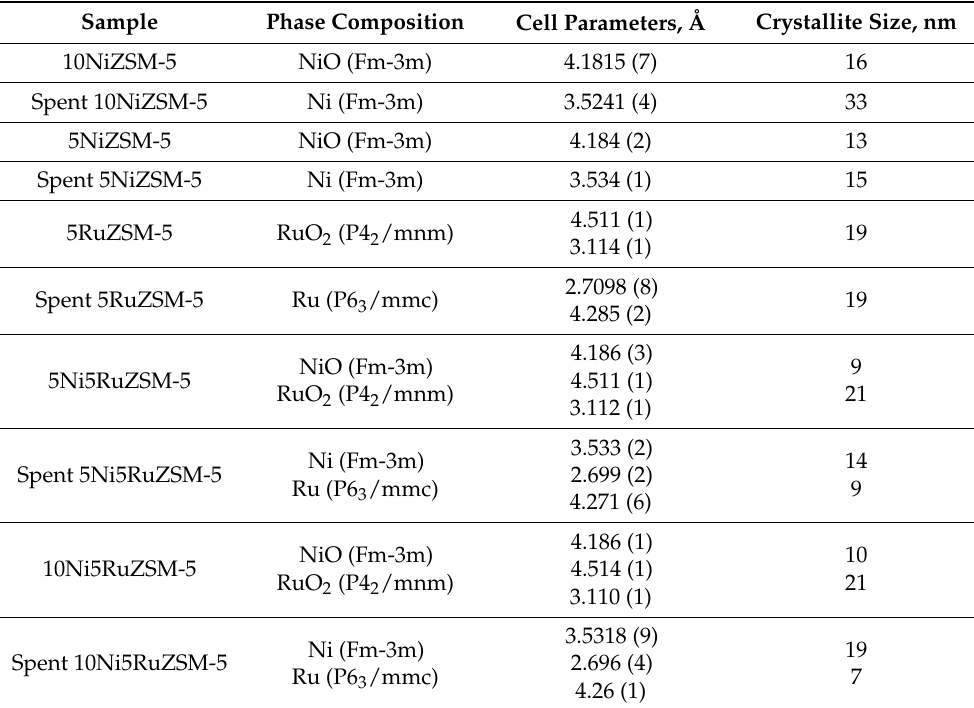
Figure 1. X-ray powder diffraction patterns of the initial, and the Ni- and Ru-modified varieties of ZSM-5 catalysts. Table 1. Physico-chemical properties of the studied catalysts.